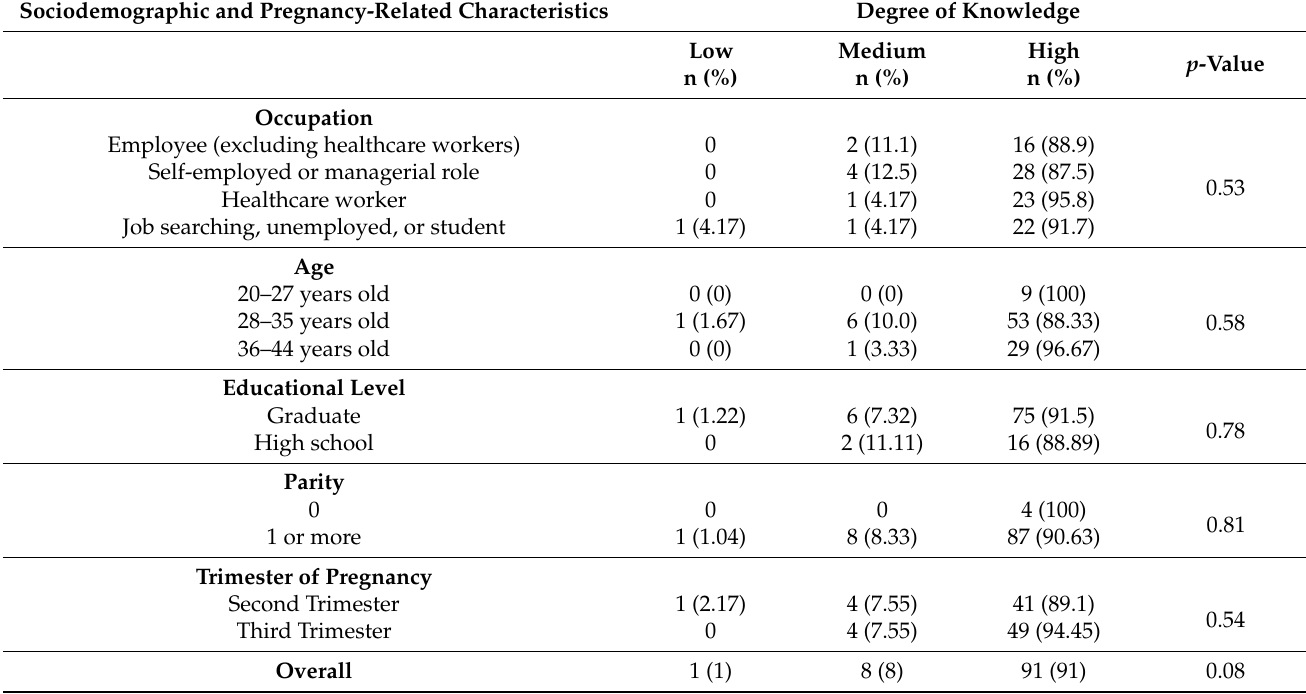
Table 5. Classification of the participants based on their degree of knowledge (N =